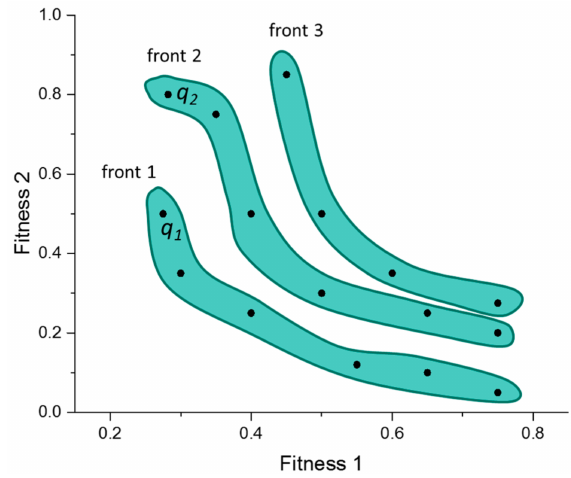
Figure 4. Classification of intermediated results in different fronts, here front 1 is equal to the Pareto front.